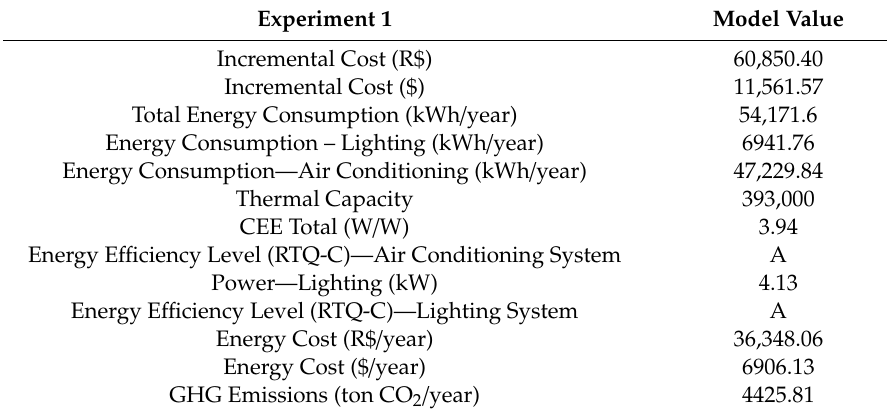
Table 5. Summary of the best fitness individual from Experiment 1—With